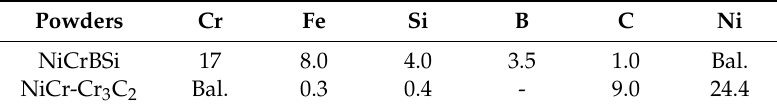
Table 1. The chemical compositions of the raw materials